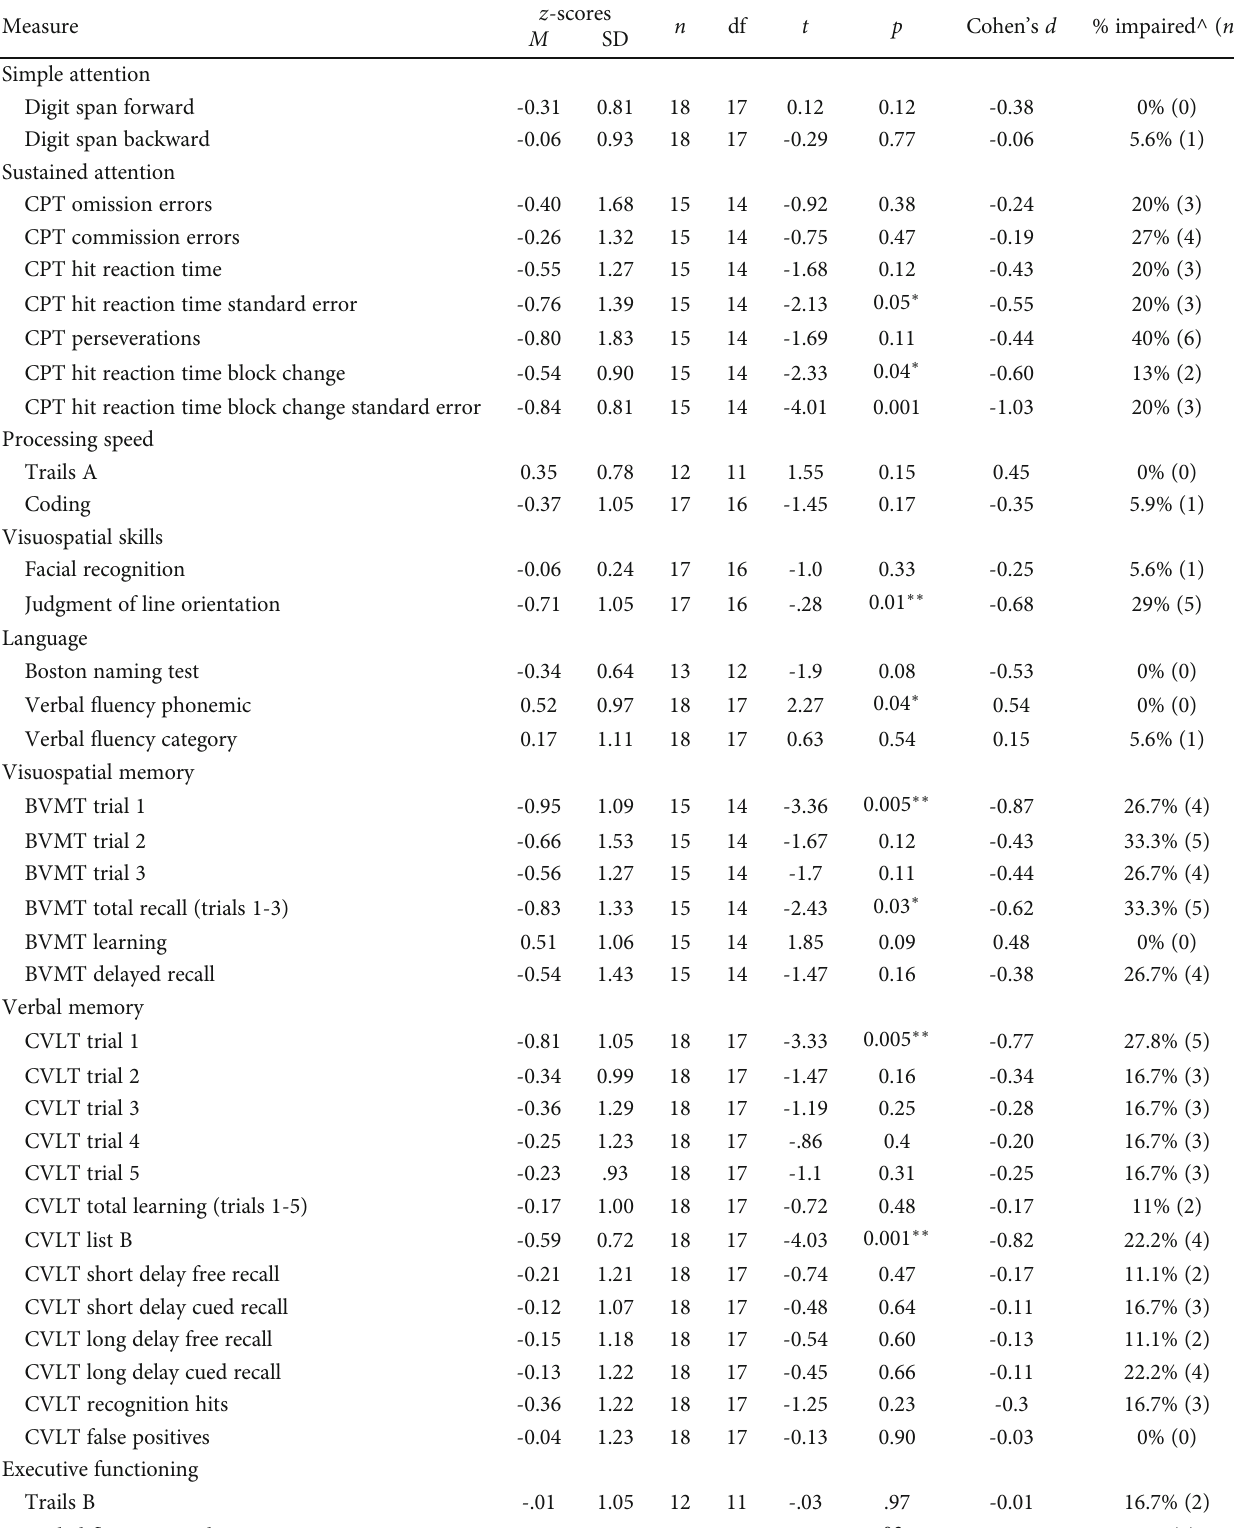
Table 4: Performance on neuropsychological